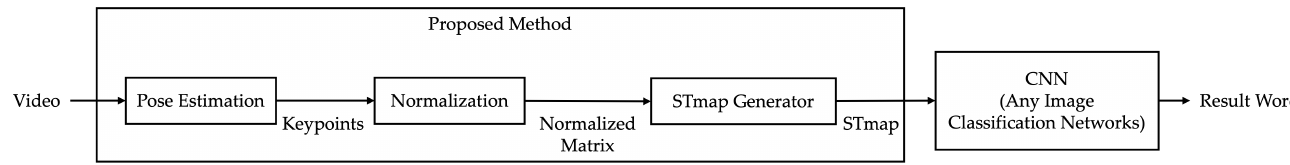
Figure 4. The structure of the proposed method and its application to the sign language recogni- tion